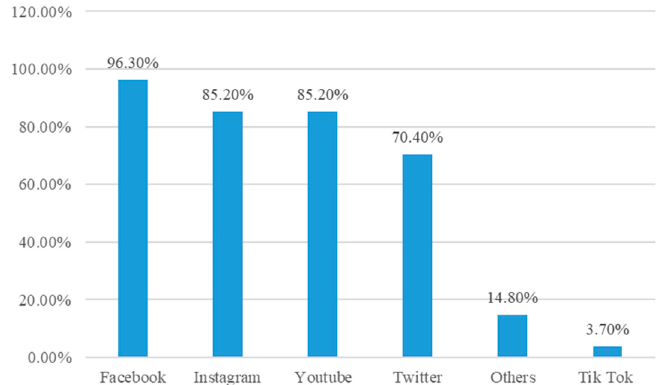
Figure 13. Use of social networks in HCM and ACS.